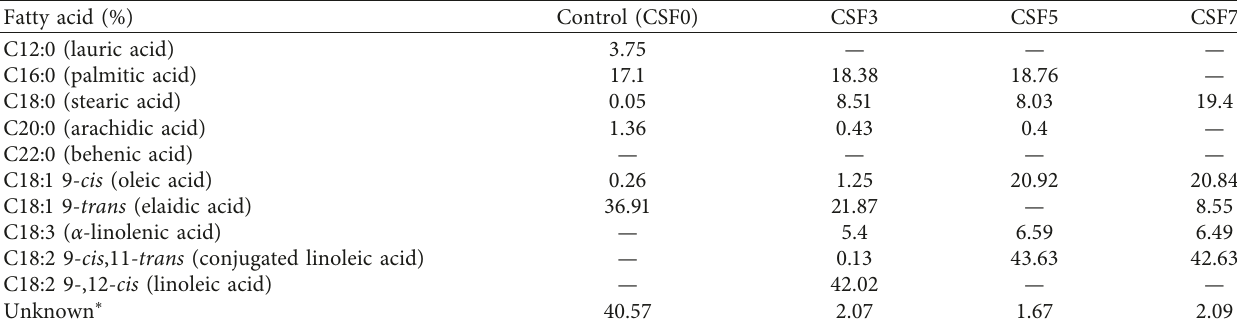
Table 8: Fatty acid profile and cholesterol content of